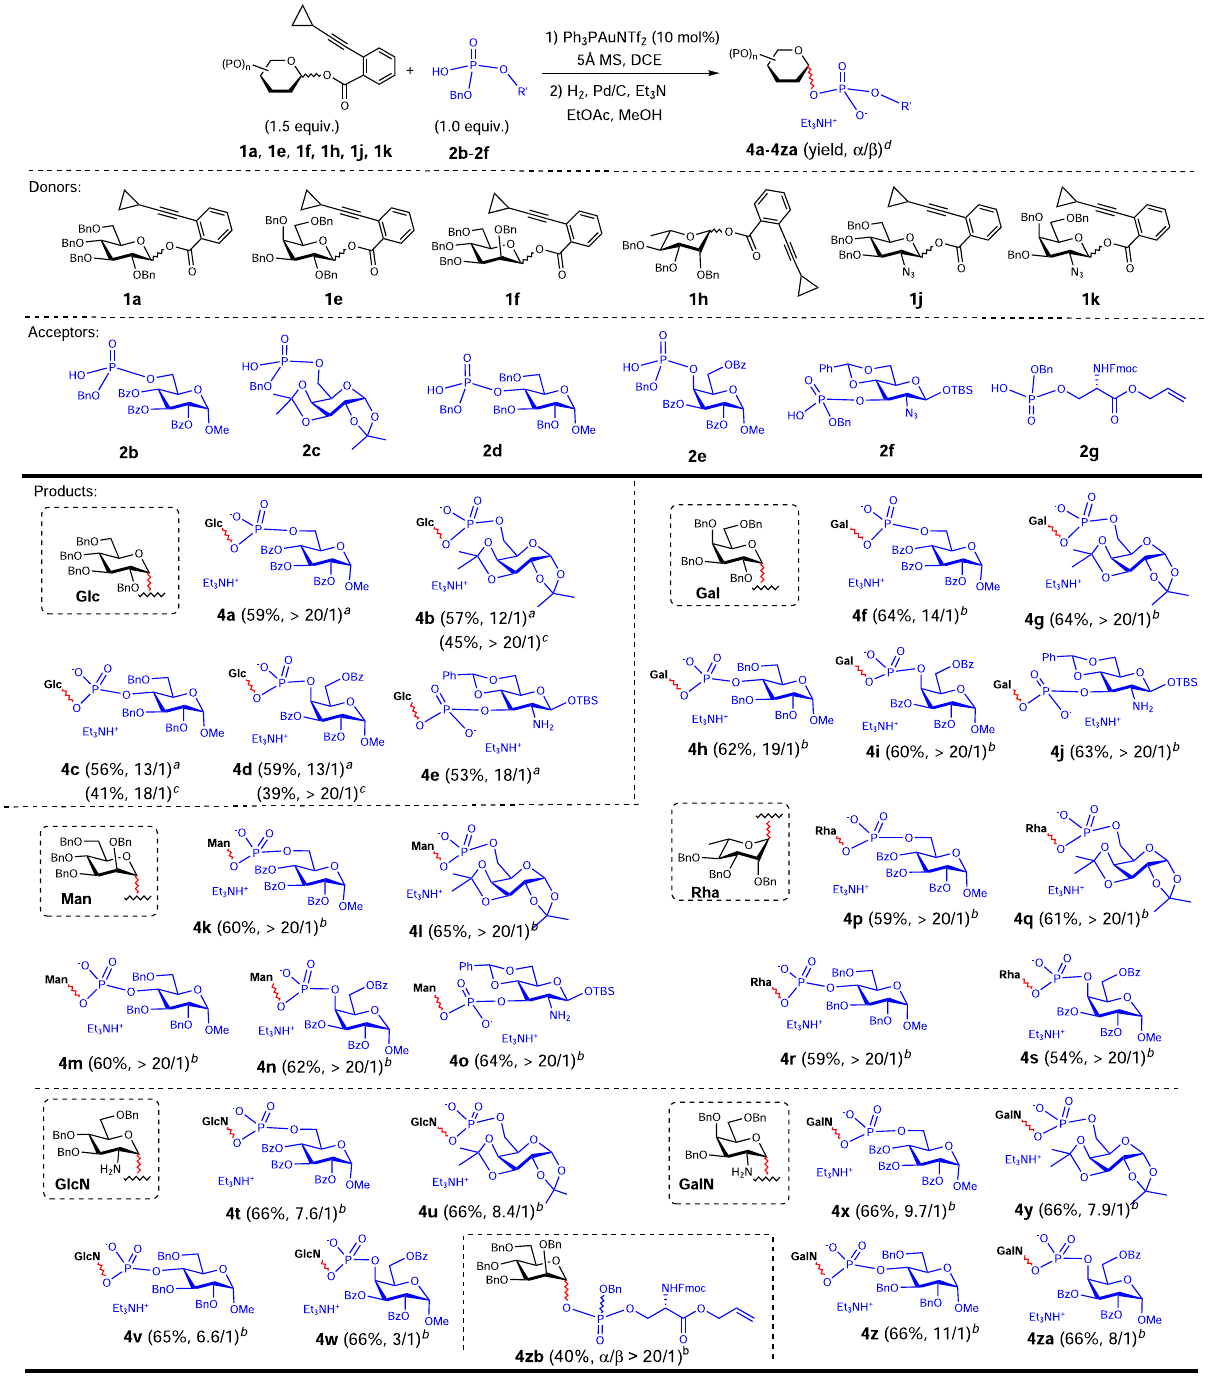
Fig. 4 The reaction scope of various acceptors of phosphoric acids. a Condition: 0 °C, 30 min then 60 °C, 2 h. b Condition: 0 °C, 30 min, then 20 °C, 2 h. c Condition: 0 °C, 30 min then 60 °C, 3 h. d Yields of α / β mixtures ( α / β mixtures not separable), and ratios were determined by 31 P NMR. TBS: tert - butyldimethylsilyl. Bn: benzyl. Bz: benzoyl. Tf: tri fl uoromethanesulfonyl. Fmoc: 9- fl uorenylmethyloxycarbonyl. In red are the formed glycosidic bonds. In blue are the acceptors of phosphoric acid and the phosphate moieties in the